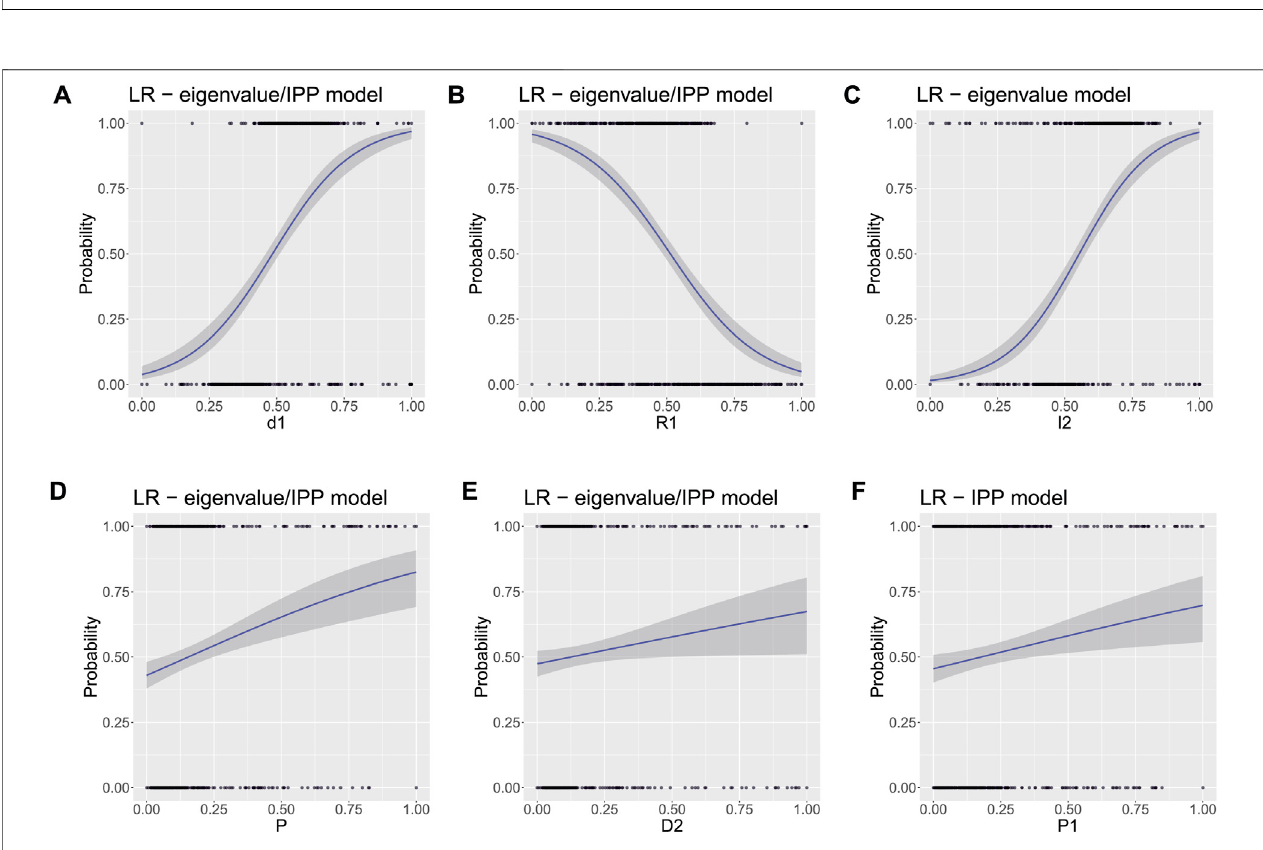
FIGURE 4 | Probability for tumor detection, calculated from LR: (A) d 1 , (B) R 1 , (C) λ 2 , (D) P , (E) D 2 , and (F) D 2 . For sub fi gures A, B, D, and E the results are comparable for both submodels, while sub fi gures C and F were computed from the eigenvalue and the IPP model, respectively ( φ 1 ≡ R 1 and λ 1 ≡ l 1 ).